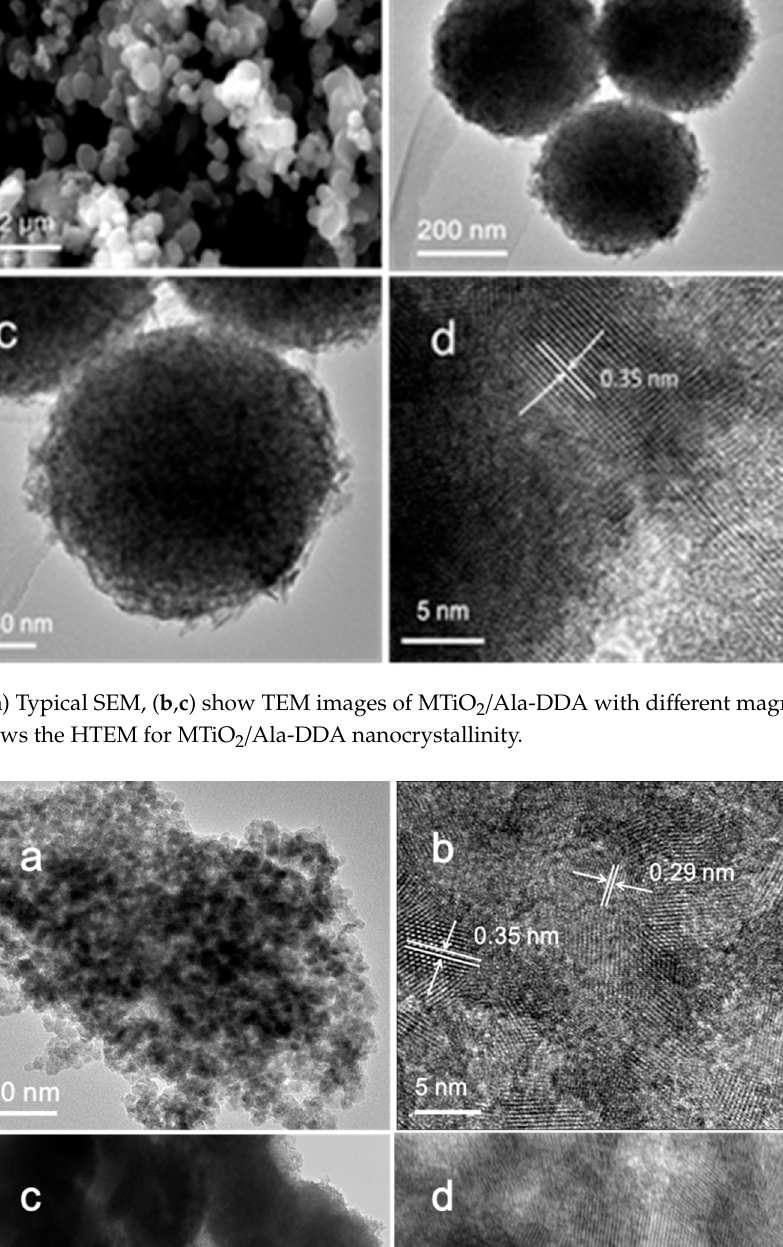
/ DDA. ( c ) TEM and ( d ) HTEM images of MTiO 2